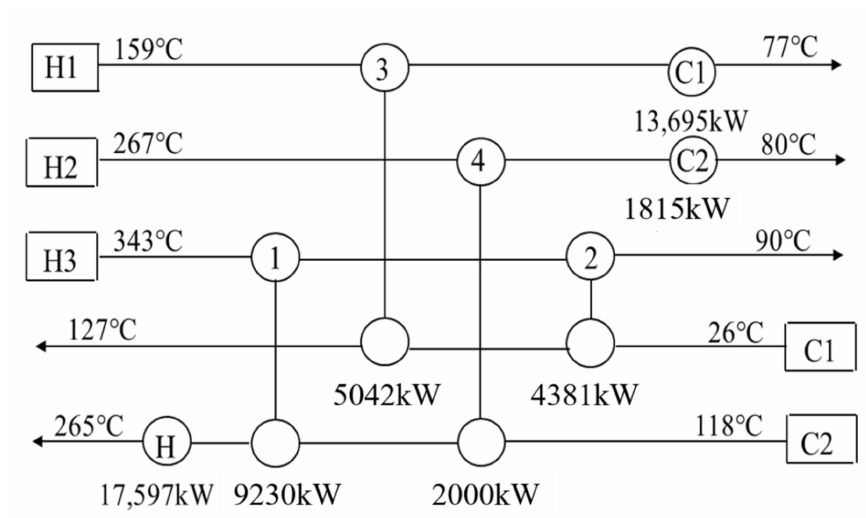
Figure 7. The original heat exchanger network for case study 1.